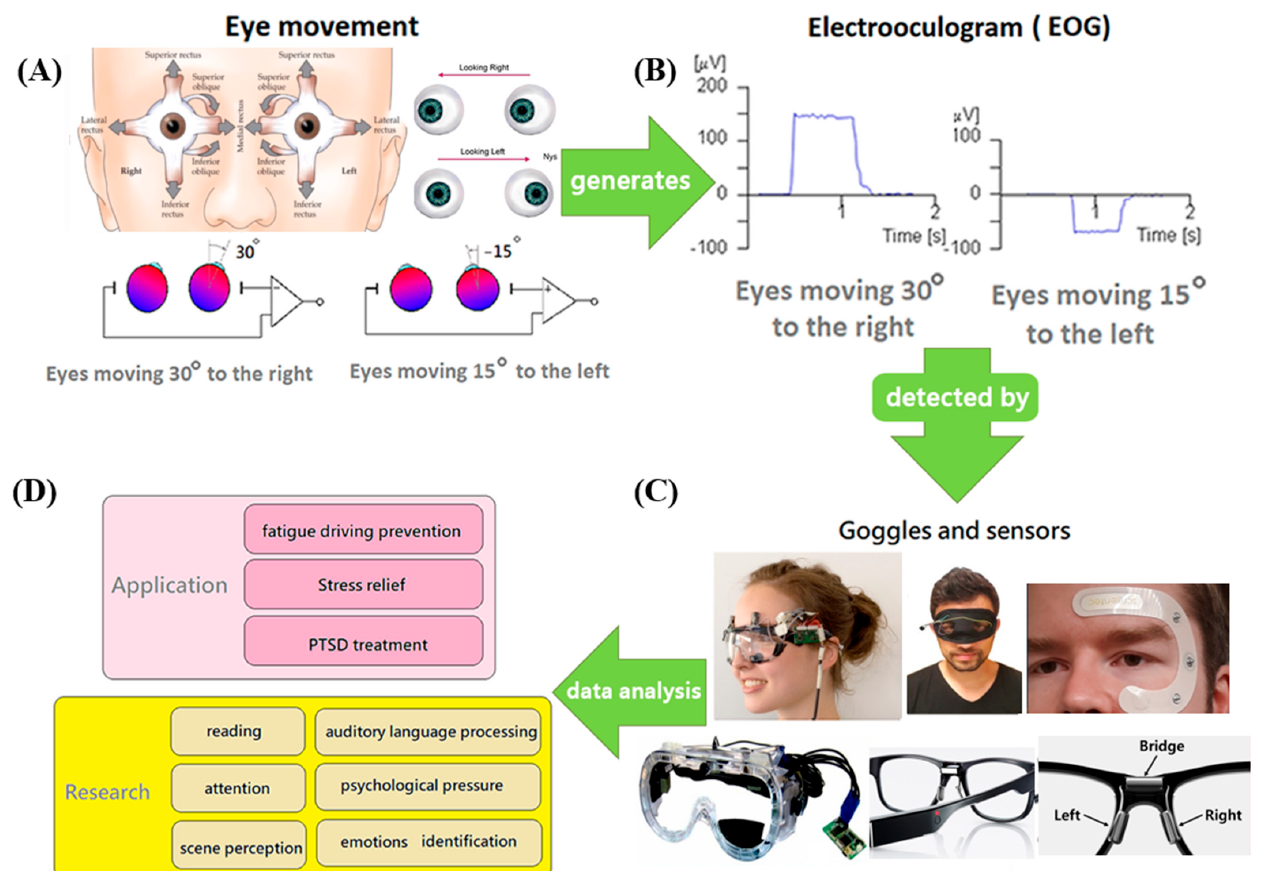
Figure 4. Wearable EOG detection device and application. ( A ) Six muscles control the fine-motor movements of each eye [93]. ( B ) Electrooculography (EOG) signals are positive when the eyes move toward the right (horizontally). In contrast, EOG signals are negative when the eye moves to the left [91,92]. ( C ) Several goggles and sensors have been developed to detect EOG signals [10,94–96]. ( D ) After data analysis, the wearables for detecting EOG could be applied in fatigued driving prevention [97], stress relief and PTSD treatment. Moreover, EOG wearables can be used as research equipment to explore the mechanisms of reading, attention, scene perception, auditory language processing, psychological pressure and emotional identification.